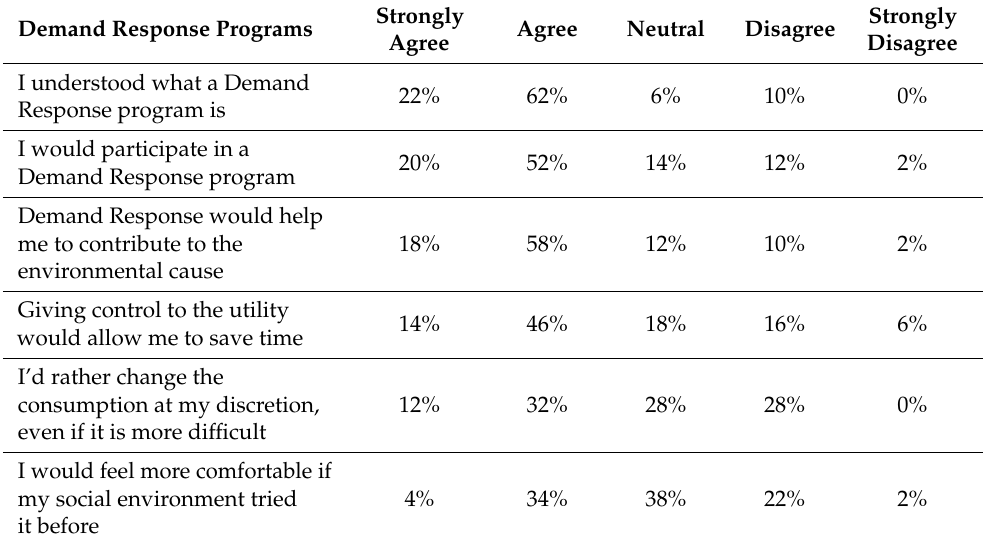
Table A3. Sentences about demand response programs—answers collected on a 5-point Likert scale.